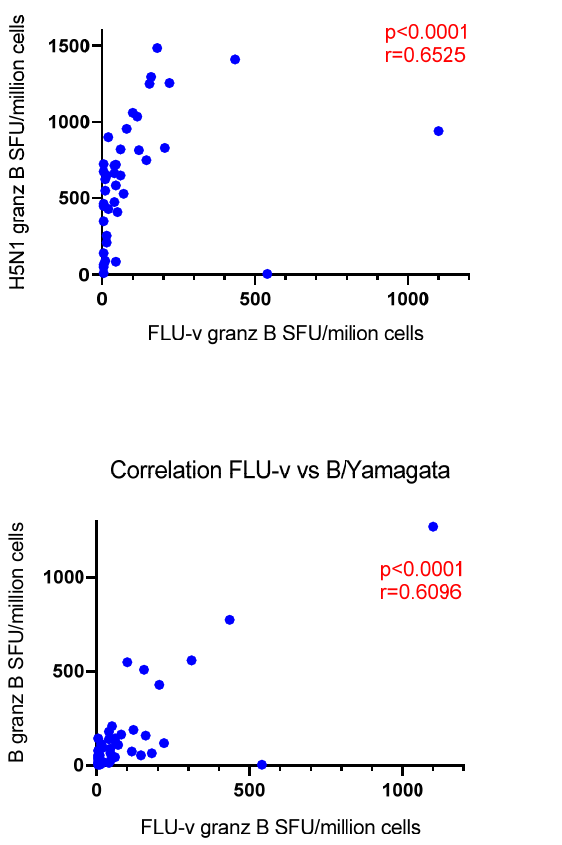
Figure 2. Correlation analysis between the number of granzyme-B-secreting cells (SFU/million cells) in response to the equimolar mix of the four synthetic peptides included in the FLU-v vaccine and in response to whole inactivated influenza strains (A/California/7/2009 (H1N1), A/Shanghai/24/1990 (H3N2), A/Vietnam/1194/2004 (NIBRG-14) (H5N1), A/Anhui/1/2013 (NIBRG-268) (H7N9), and B/Brisbane/9/2014 (Yamagata lineage)) on day 42 in the FLU-v vaccinated group. Correlation coefficients (r) and p -values according to the Spearman analysis are indicated.